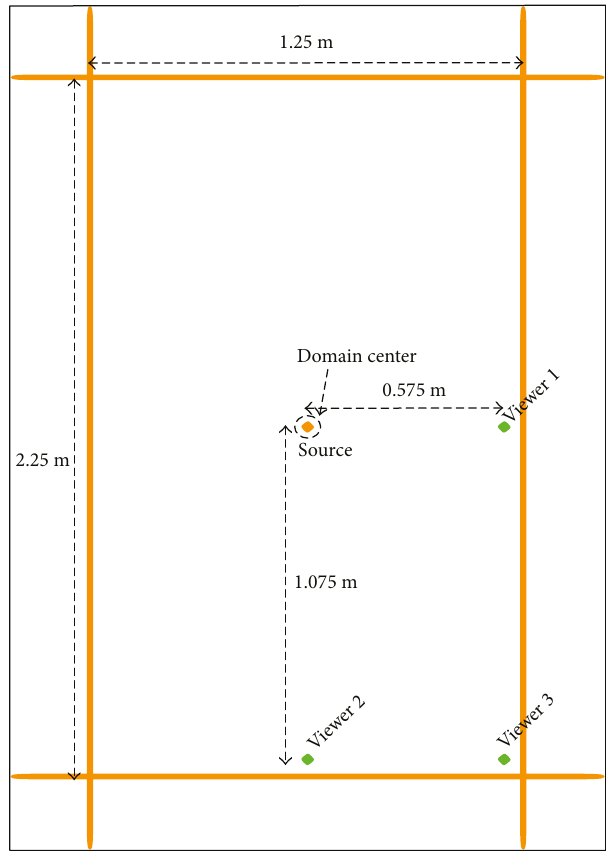
Figure 5: Con fi guration for the free space propagation scenario. Orange lines indicate the beginning of the absorption region (CPML); the orange dot in the centre indicates the location of the source and the green dots indicate the position of the